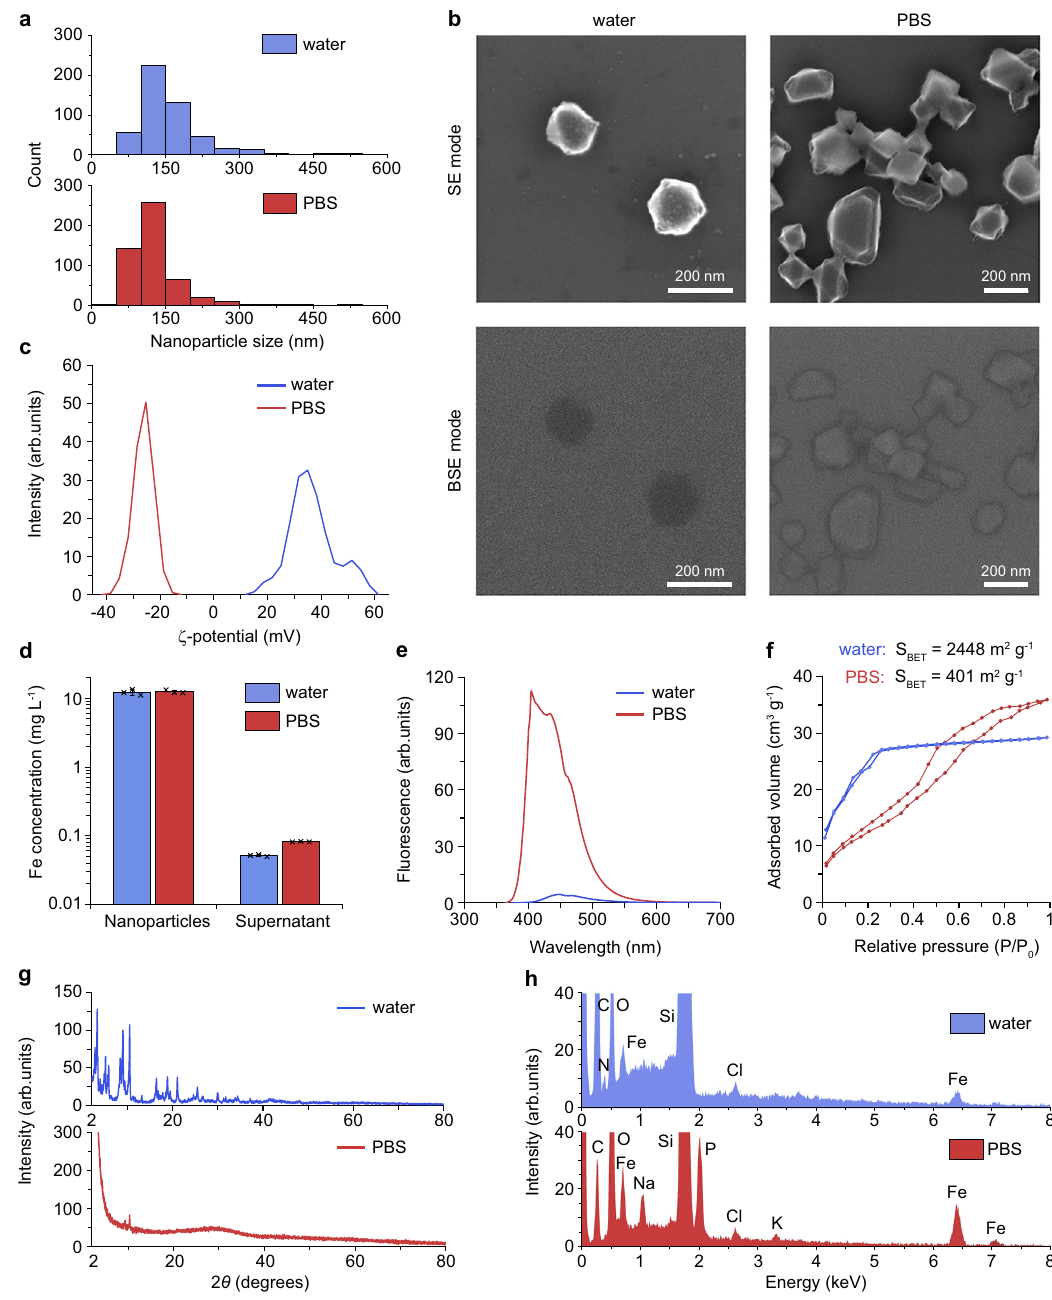
Fig. 3 | MIL-101 nanoparticle degradation mechanism. Results of MIL-101 nano- particle (NP) degradation analysis after 24-h incubation in PBS and water at the concentration200mgL − 1 aremarkedwithred andblue,respectively(columnsand lines). a Histograms of the particle size distribution based on scanning electron microscopy analysis ( n =1 experiment, 500 particles were analysed for each his- togram). b Electron micrographs obtained using in-beam secondary electron (SE) mode (top row) and in-beam back-scattered electron (BSE) mode (bottom row) of MIL-101 NPs incubated in water (left) or PBS (right), n =1 experiment. Scale bars=